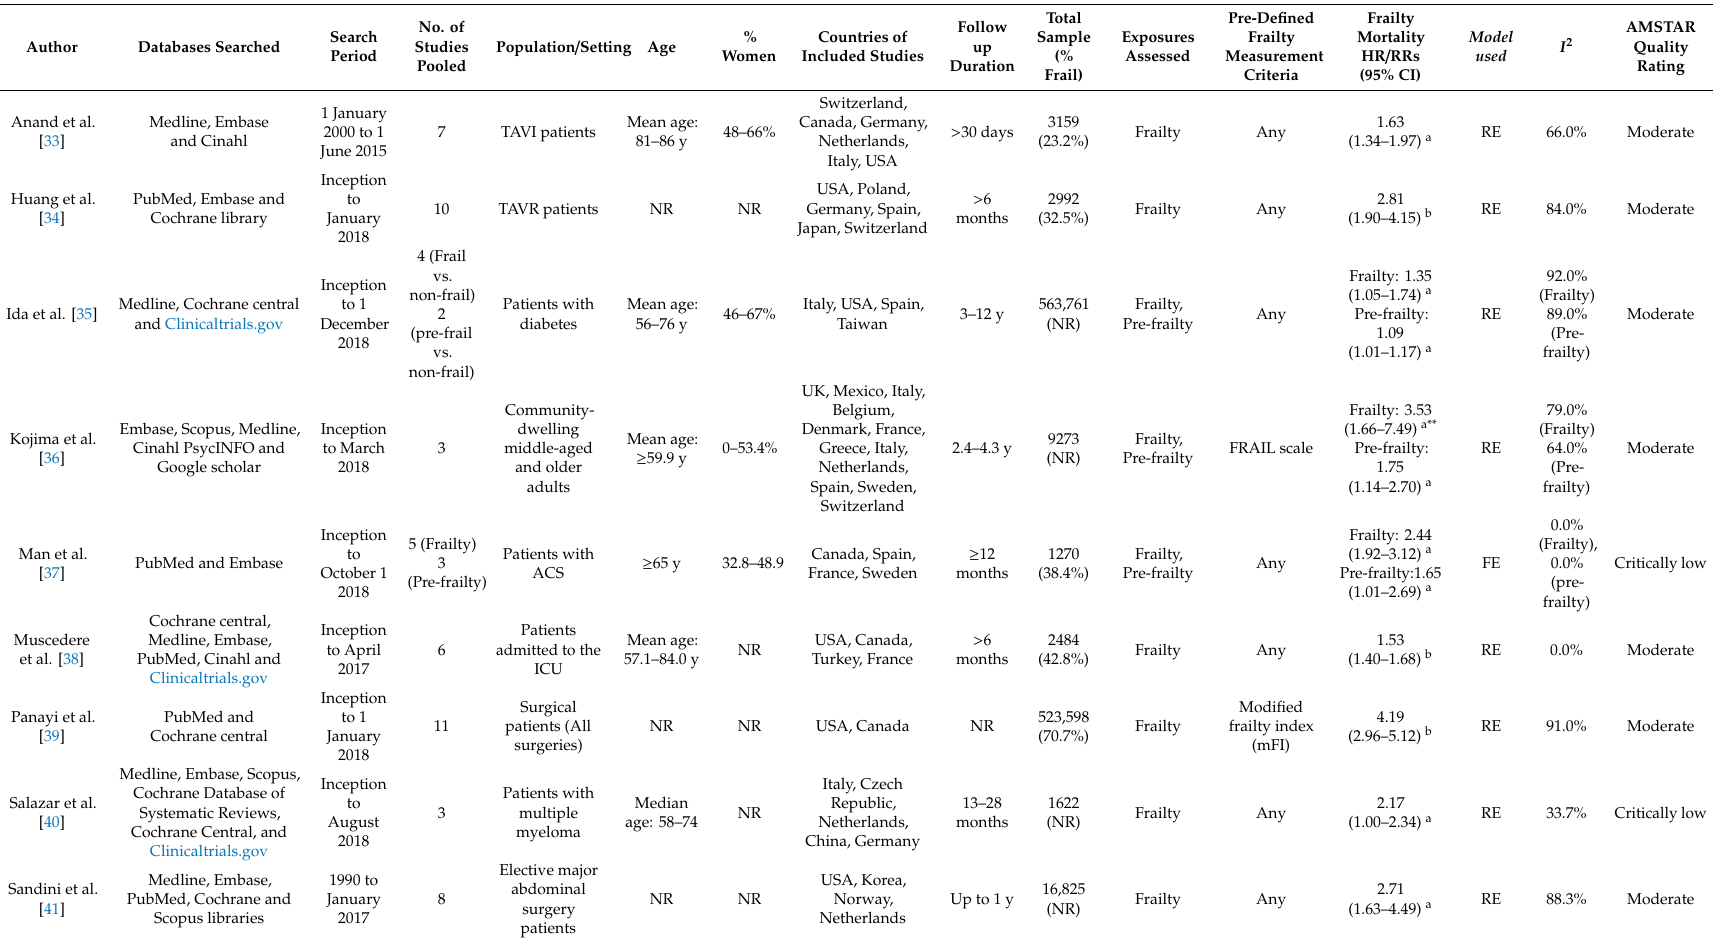
Table 1. Descriptive characteristics of the included